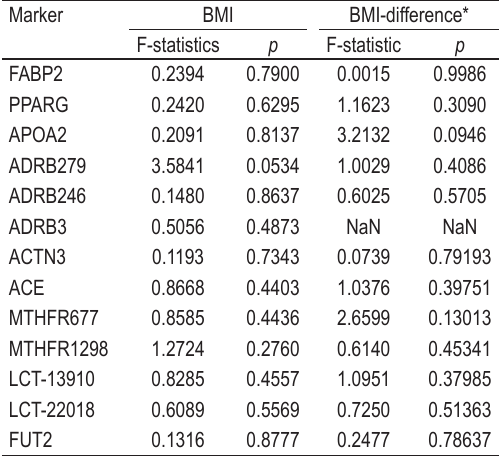
TABLE 5. Single‑locus F‑test results of the gene polymorphisms and BMI values association Marker BMI BMI‑difference*